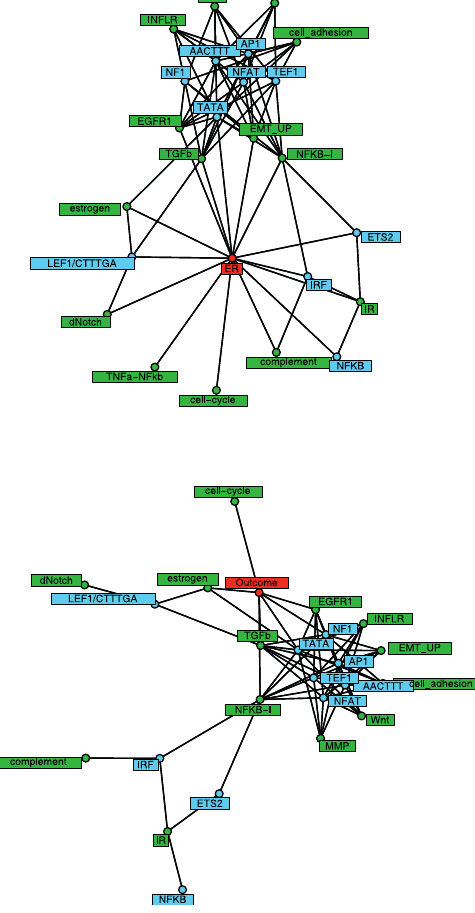
Figure 8. Association Networks Average association networks shown for ER status (A) and clinical outcome (B). Only edges between phenotypes, pathways, and tran- scription factors are shown (for the sake of clarity, edges between any two pathways, transcription factors, or phenotypes are not shown). An edge between two nodes was defined if the association between the two nodes was present in at least three out of the four studies, as predicted by the KernelICA algorithm. The diagrams are colour-coded as follows: phenotype (red), pathways (green), and transcription factors/ binding motifs (blue). INFLR, inflammatory response; TM, tyrosine